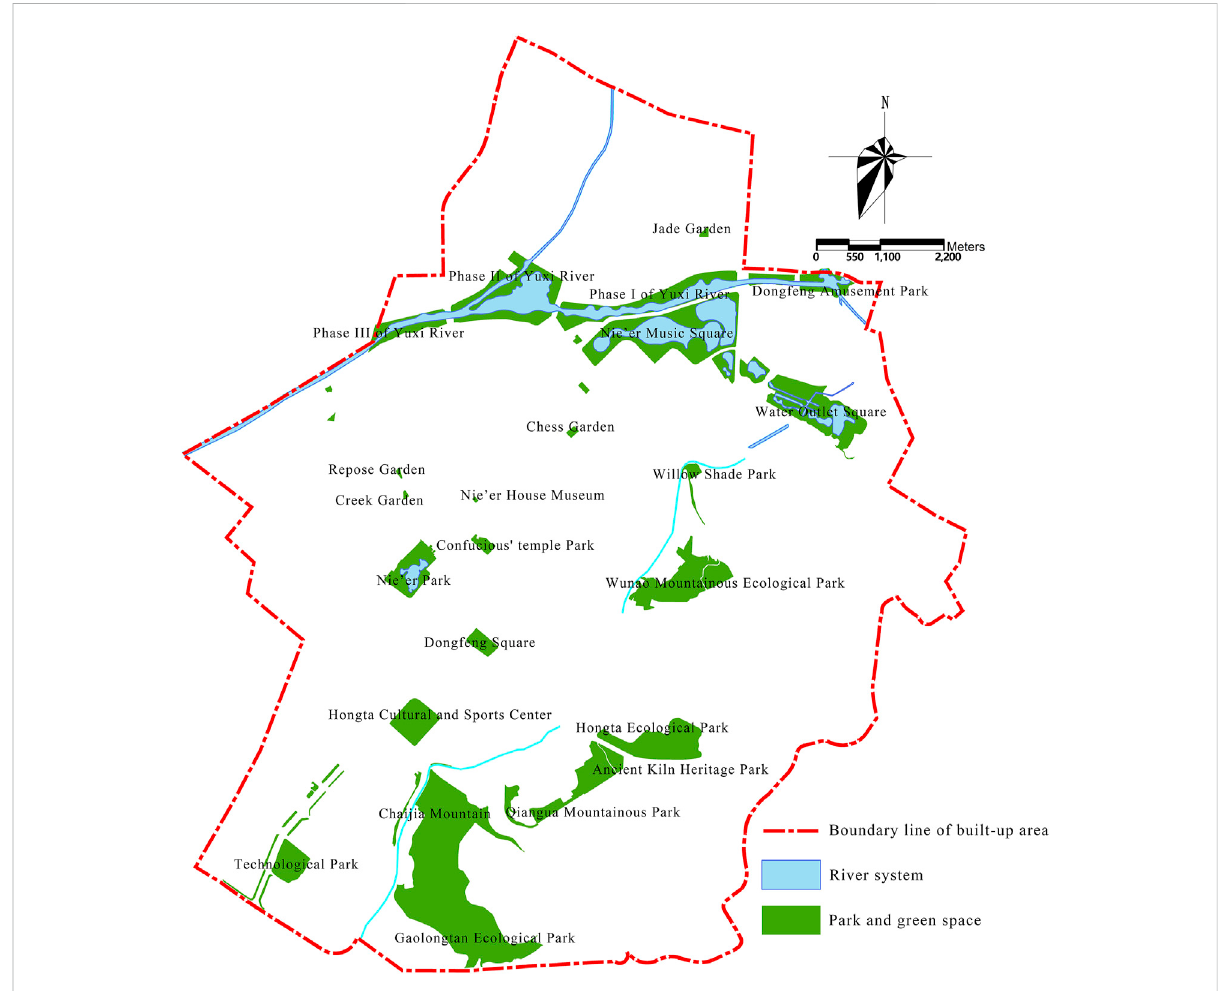
FIGURE 3 Spatial distribution of park and water in Yuxi City